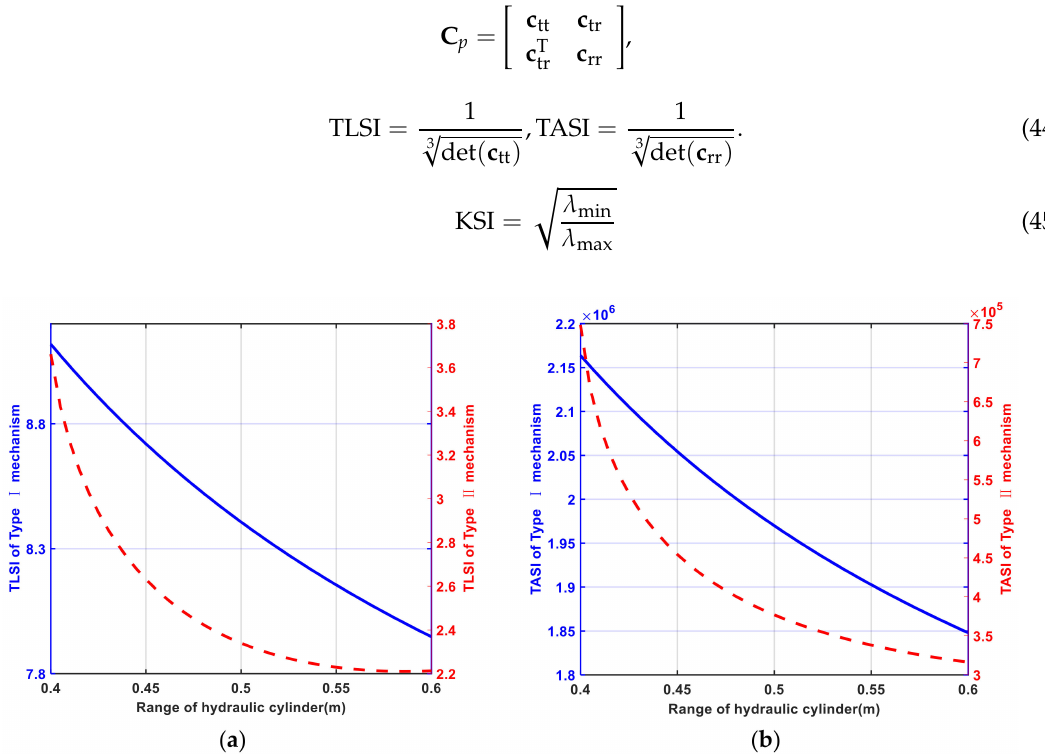
Figure 12. TLSI and TASI variation caused by a range of hydraulic cylinder. ( a ) TLSI index variation of two type mechanisms; ( b ) TASI index variation of two type mechanisms; The blue solid line stands for index of typeI mechanism, the red dashed line stands for index of type II